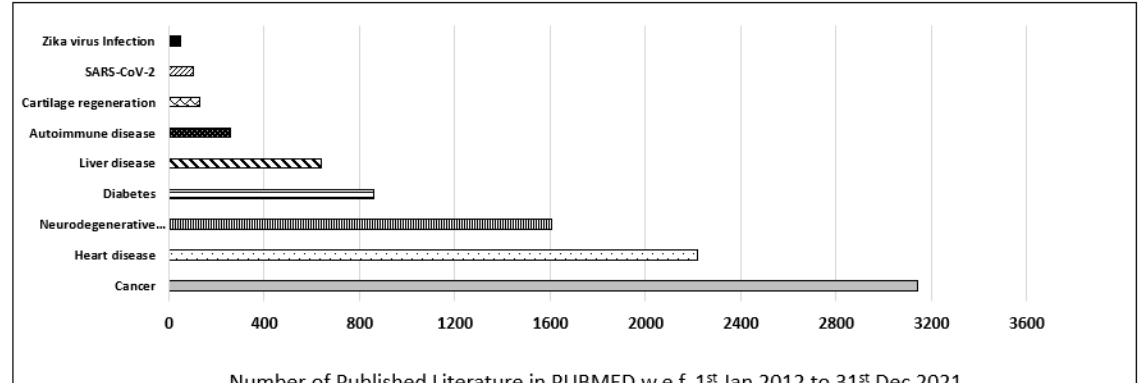
Figure 2. Published data for iPSCs research in the last decade. Comparison of different diseases such as cancer, heart disease, neurodegenerative disease, diabetes, liver disease, autoimmune disease, cartilage regeneration, Zika virus, and SARS-CoV-2 based on scientific research published in PUB- MED in the last decade (w.e.f. 1 January 2012 to 31 December 2021).